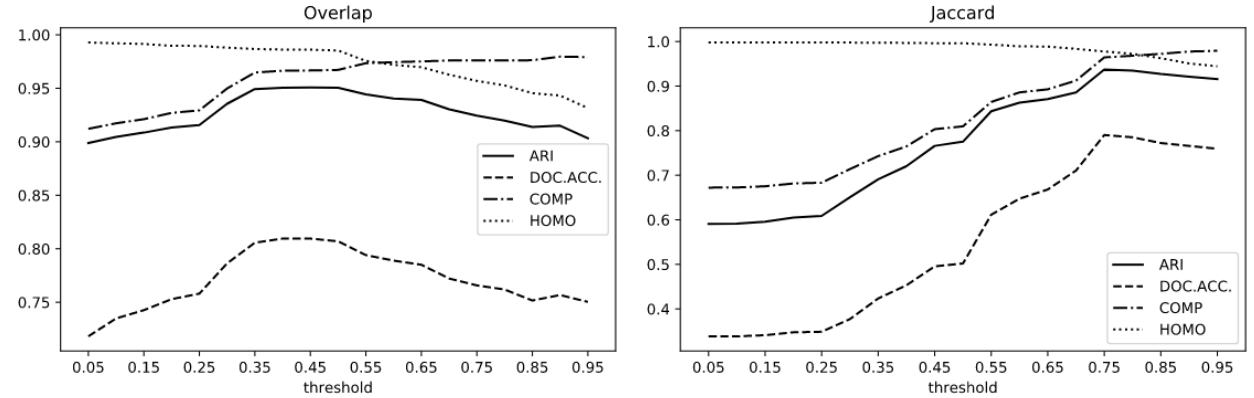
Figure 5. ARI, Document Accuracy, Completitude and Homogeneity for Overlap and Jaccard by threshold value.